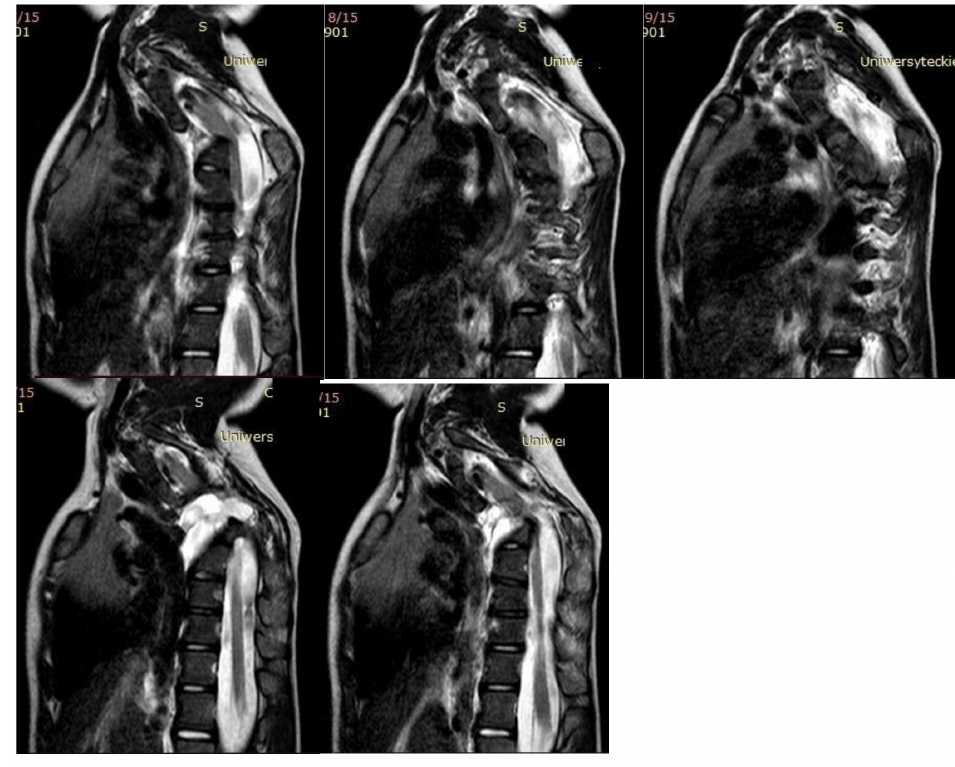
Figure 3. MRI of the five-year-old girl before surgical treatment. Angio-CT examination of blood vessels in the neck, chest, and abdomen showed no pathological structure. The patient underwent posterior vertebral column resection of T3– T4 (the blocked vertebrae) using the costotransversectomy approach (Figures 4 and 5) with posterior pedicle screw stabilization and fusion between C7 and T9.